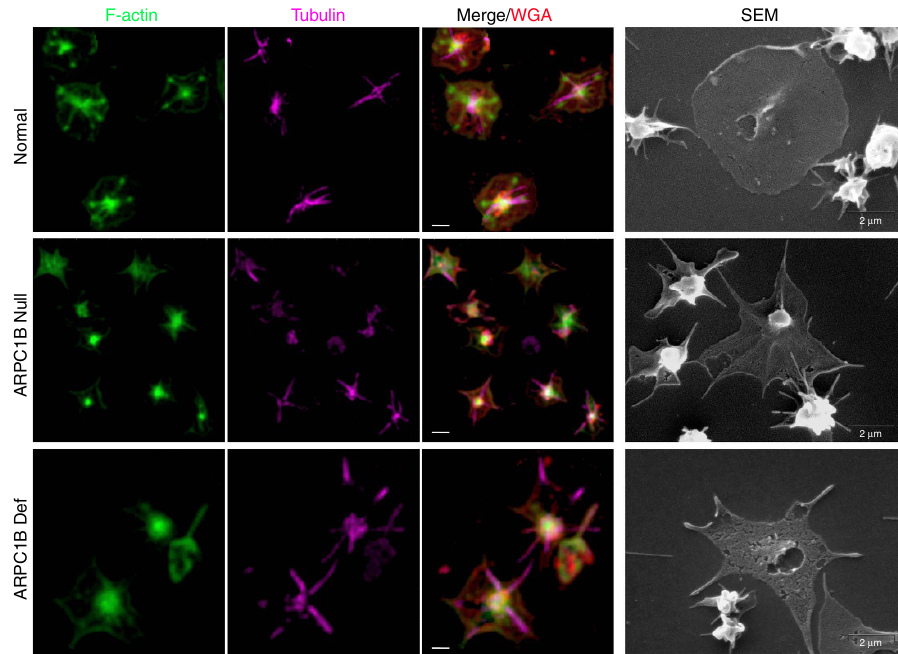
Figure 6 | Abnormal spreading of ARPC1B-deficient platelets on fibrinogen. Washed platelets were allowed to spread on fibrinogen-treated coverslips for 45min prior to fixation and imaging by SEM (right column; bars ¼ 2 m m), or by spinning disc laser fluorescence confocal microscopy (left columns; 3D renders of deconvolved z-series, bars ¼ 1 m m) after surface staining with wheat germ agglutinin (WGA; red), staining for F-actin with phalloidin (green) and immunostaining for alpha tubulin (magenta). Maximally spread platelets from a normal donor (top row) typically show fully formed lamellipodia with thin tubulin filaments and multiple F-actin filaments intersecting with podosome-like actin nodules. In contrast, maximally spread platelets from both ARPC1B-null (middle row) and ARPC1B-deficient (bottom row) patients tend to form spiky filopodial-lamellipodial structures lacking podosomes that sometimes show elongated actin filaments (see also Fig.